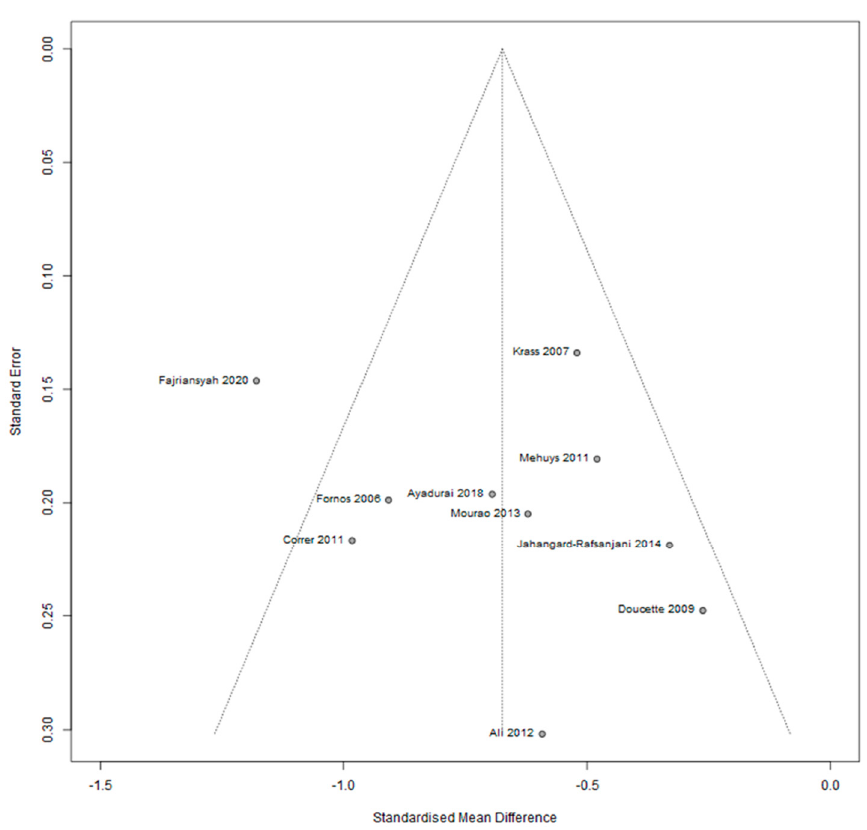
Figure A3. Funnel